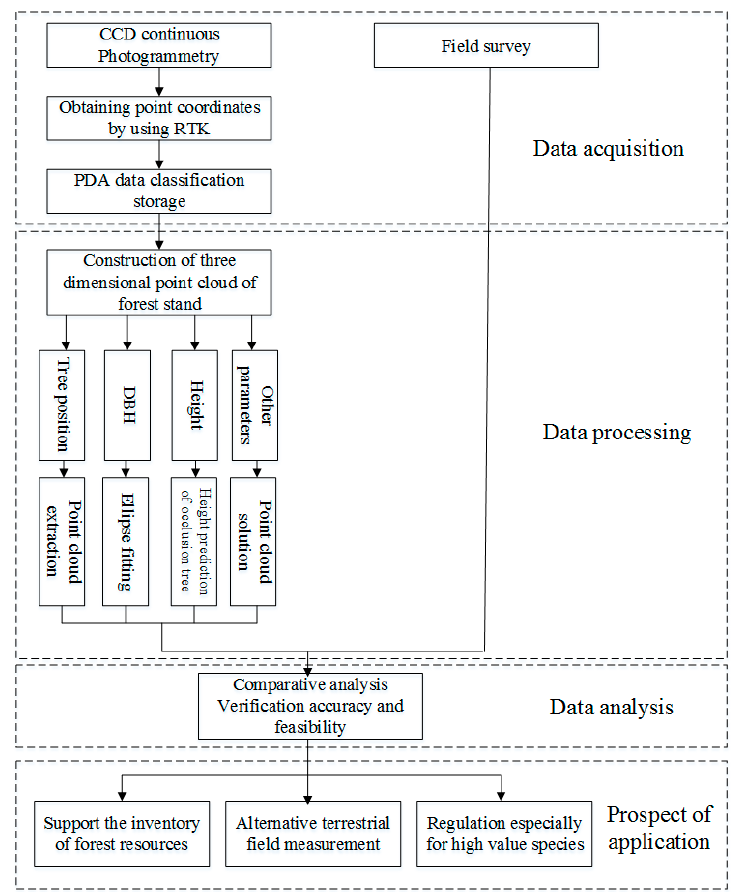
Figure 1. Workflow diagram exhibiting the stepwise processing of the data.